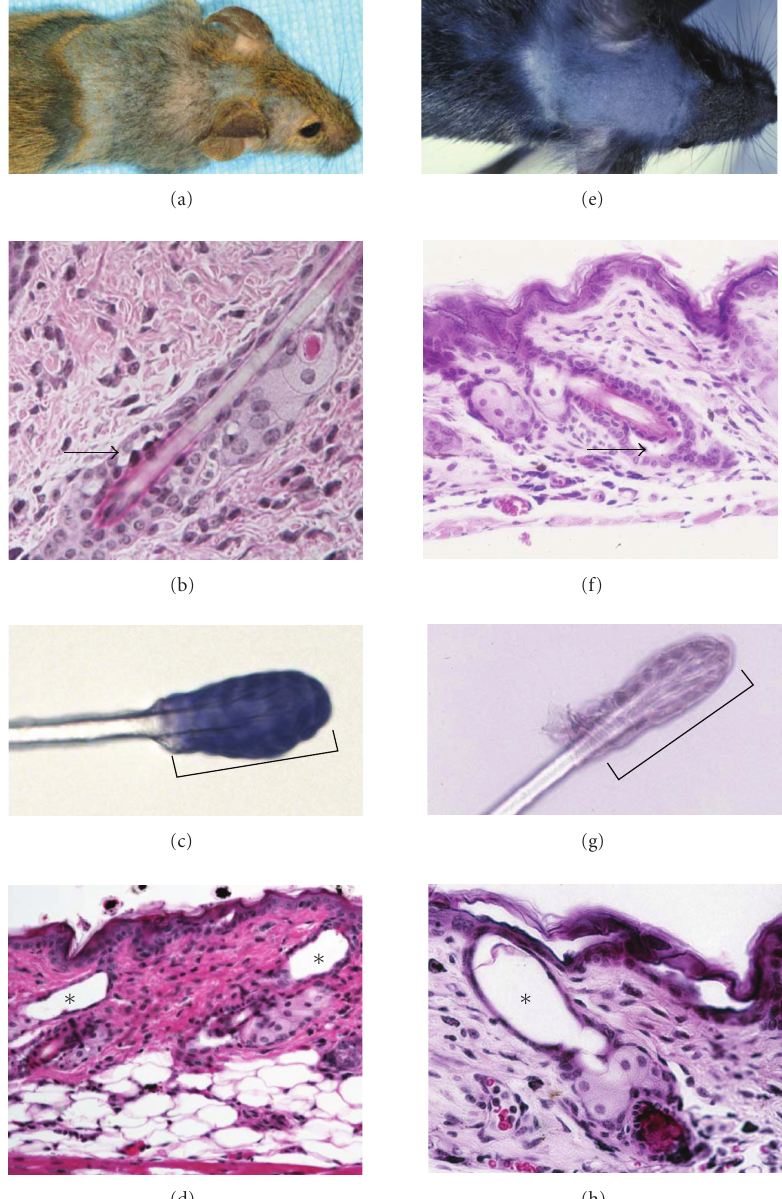
Figure 3: Hair loss phenotype of conditional Dsc3 null ((a), (b), (c), (d)) and conventional Dsg3 null mice ((e), (f), (g), (h)). Both mouse lines show cyclic hair loss beginning around the time of weaning when the hair follicles on the back of the head enter telogen, the resting phase of the hair growth cycle. (a) Hair loss of a 56-day-old conditional Dsc3 null mouse and (b) a 53-day-old Dsg3 null mouse. (b and f) Acantholysis between the two cell layers surrounding the telogen hair club leads to loss of the hair shaft. Arrows indicate separation of the two cell layers. Note that early lesions are shown, that is, before the hair shaft is actually lost . (c and g) Telogen hairs with a single epithelial cell layer surrounding the club hair (brackets, nuclei of the epithelial sheet surrounding the clubs are stained in dark (c) and light (g) blue, resp.). In both cases, hair loss leads to the development of dermal cysts ((d and h); stars). Note that the hair loss in both mouse lines appears to follow the same mechanism, that is, loss of cell-cell adhesion between the two epithelial cell layers which anchor the telogen hair in the